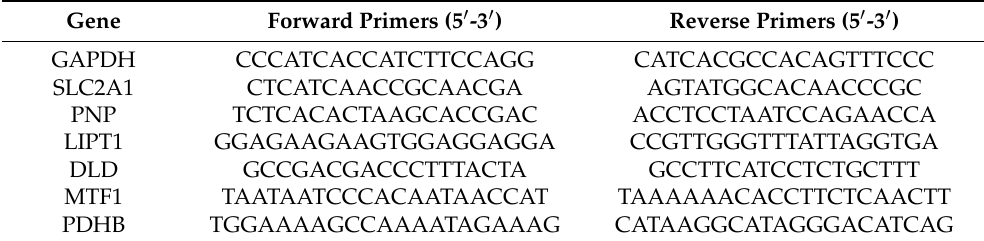
Table 1. Specific sequences of the primers used in the polymerase chain reaction (PCR) assay.